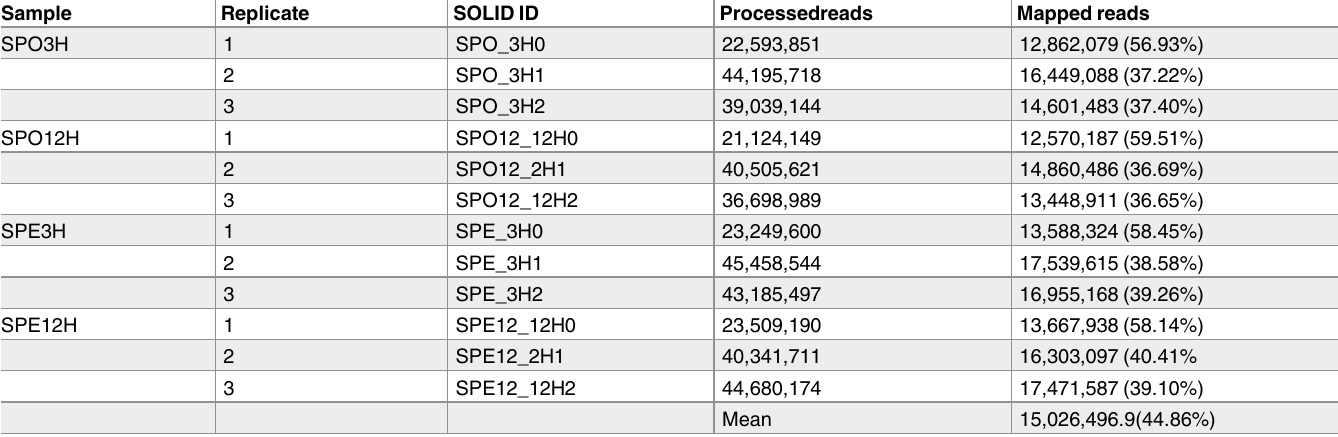
SPO3H—schistosomula cultured for 3 hours in portal serum; SPO12H—schistosomula cultured for 12 hours in portal serum;